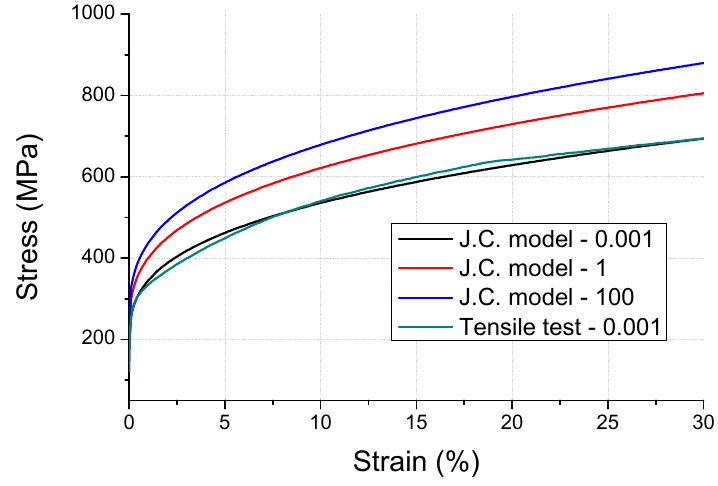
Figure 2. Stress–strain curve of SUS304 based on strain rate variations.